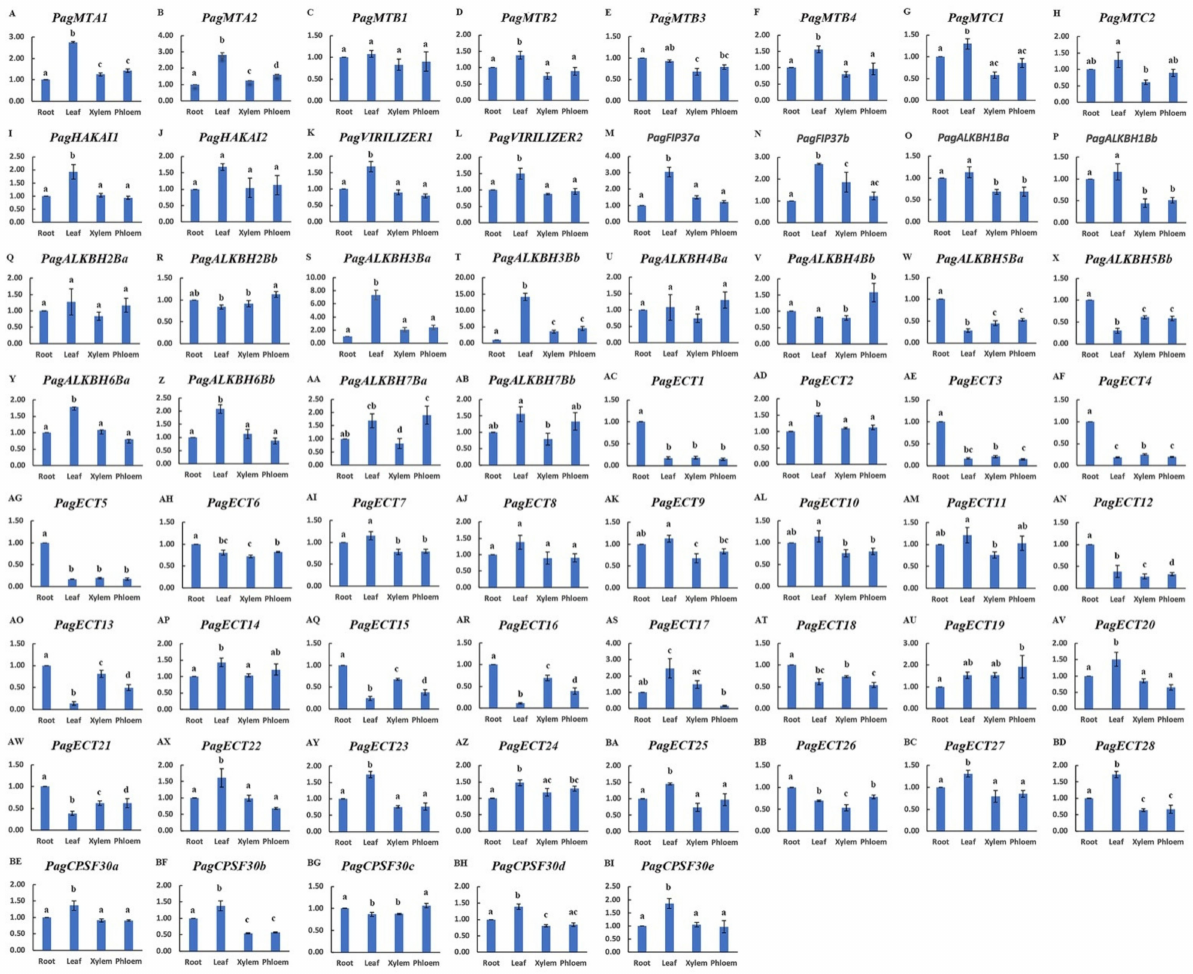
Figure 5. qPCR validation of 61 m 6 A pathway genes in tissues. Figure ( A )–( BI ) showed the expression level of 61 genes in differential tissues. One-way ANOVA was calculated using IBM SPSS 19 software. The a, b, c and d indicated whether the difference was significant. The same letter marked in the same gene among different tissues indicated no significant difference, and different letters indicated significant